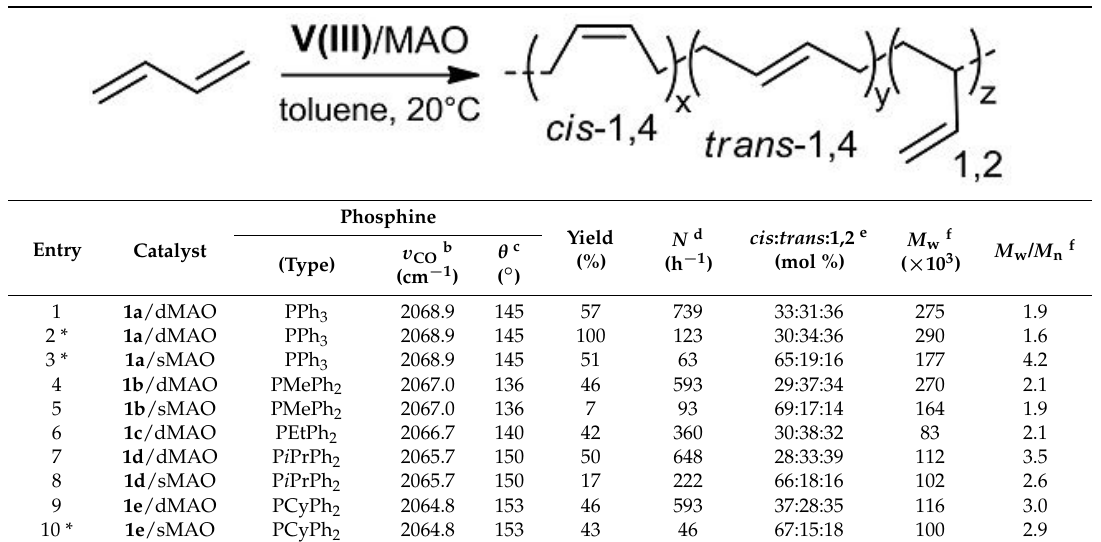
Table 2. Polymerization of 1,3-butadiene with the phosphine V(III) complexes a